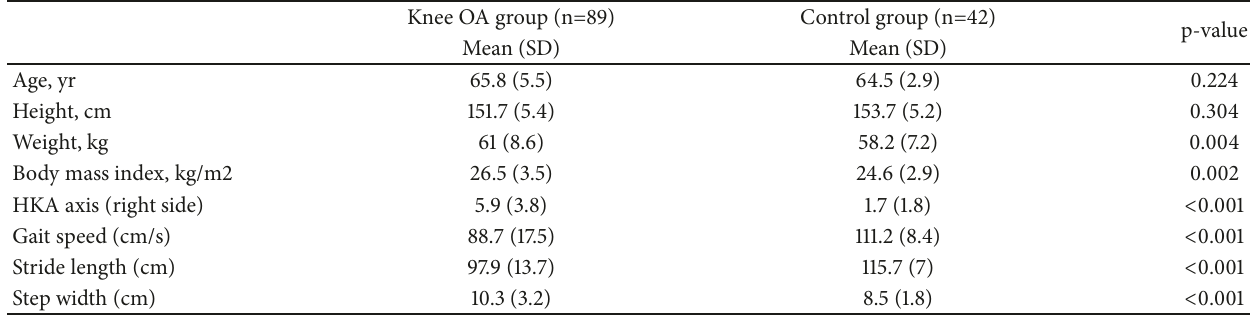
Table 1: Characteristics of knee OA and control